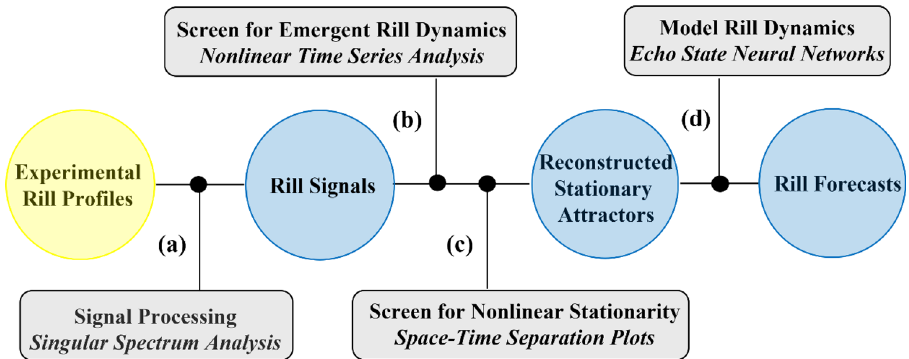
Figure 2. Workflow for reconstructing spatial dynamics from experimental rill-bed profiles. ( a ) We applied singular spectrum analysis to separate signal from noise in rill profiles and remove low-frequency trend components from the signal to isolate higher-frequency cyclical components expected to contain step-pool units and to promote nonlinear stationarity. ( b ) We screened for emergent nonlinear-deterministic dynamics in detrended rill signals with nonlinear time series methods . We reverse-engineered (reconstructed) rill-bed morphology dynamics from each detrended rill signal with time-delay embedding, and statistically tested whether apparent nonlinear structure in reconstructed dynamics was likely mimicked by a linear-stochastic process with surrogate data testing. ( c ) We used space–time separation plots to screen for nonlinear